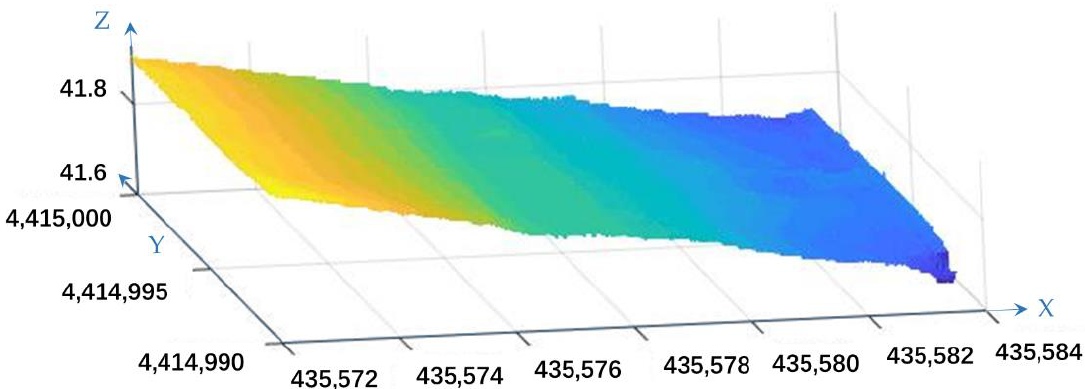
14 of 25 Figure 12. Results of road surface segmentation: ( a ) 3D view; ( b ) close-up views of road edges pro- jected in the XOZ plane.